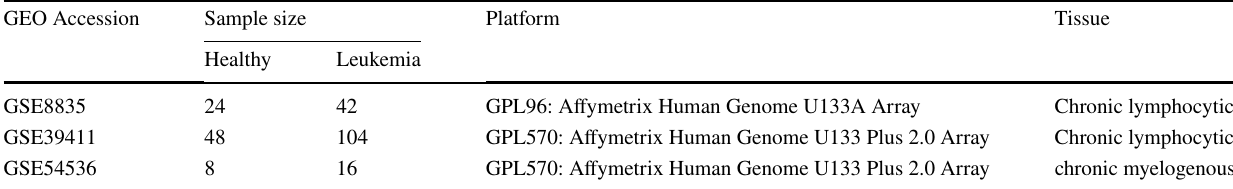
Table 1 List of datasets used in the meta-analysis GEO